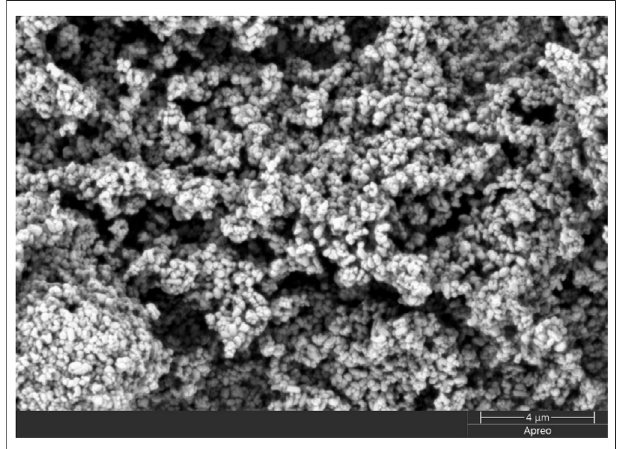
FIGURE 5 | SEM image of the aerosol employed in the present